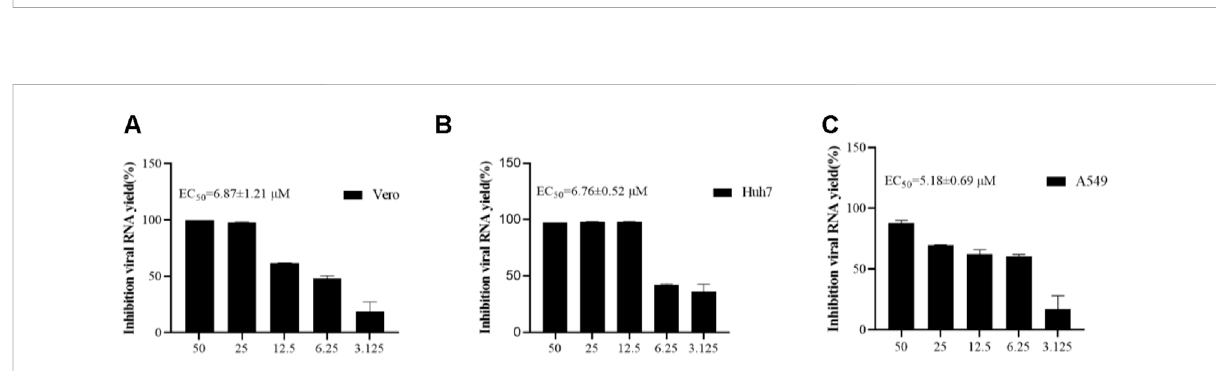
FIGURE 7 Compound 4w inhibits the synthesis of ZIKV RNA. (A) Flow chart of four different drug treatments; (B) Determination of viral load in cell supernatantsafterfourdifferentdrugtreatments,VS.post-treatment,* p < 0.05;** p < 0.01;*** p < 0.001;**** p < 0.0001; (C) experimentalprocedure oftime-sharingwithdrawal. (D) After drug withdrawalatdifferenttime points, thevirusload inthecells wasmeasured for24 hafter drug withdrawal.